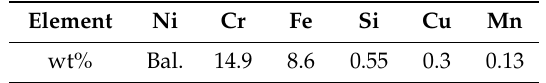
Table 2. Resistivity of the main constituents of the film at 20 ◦ C